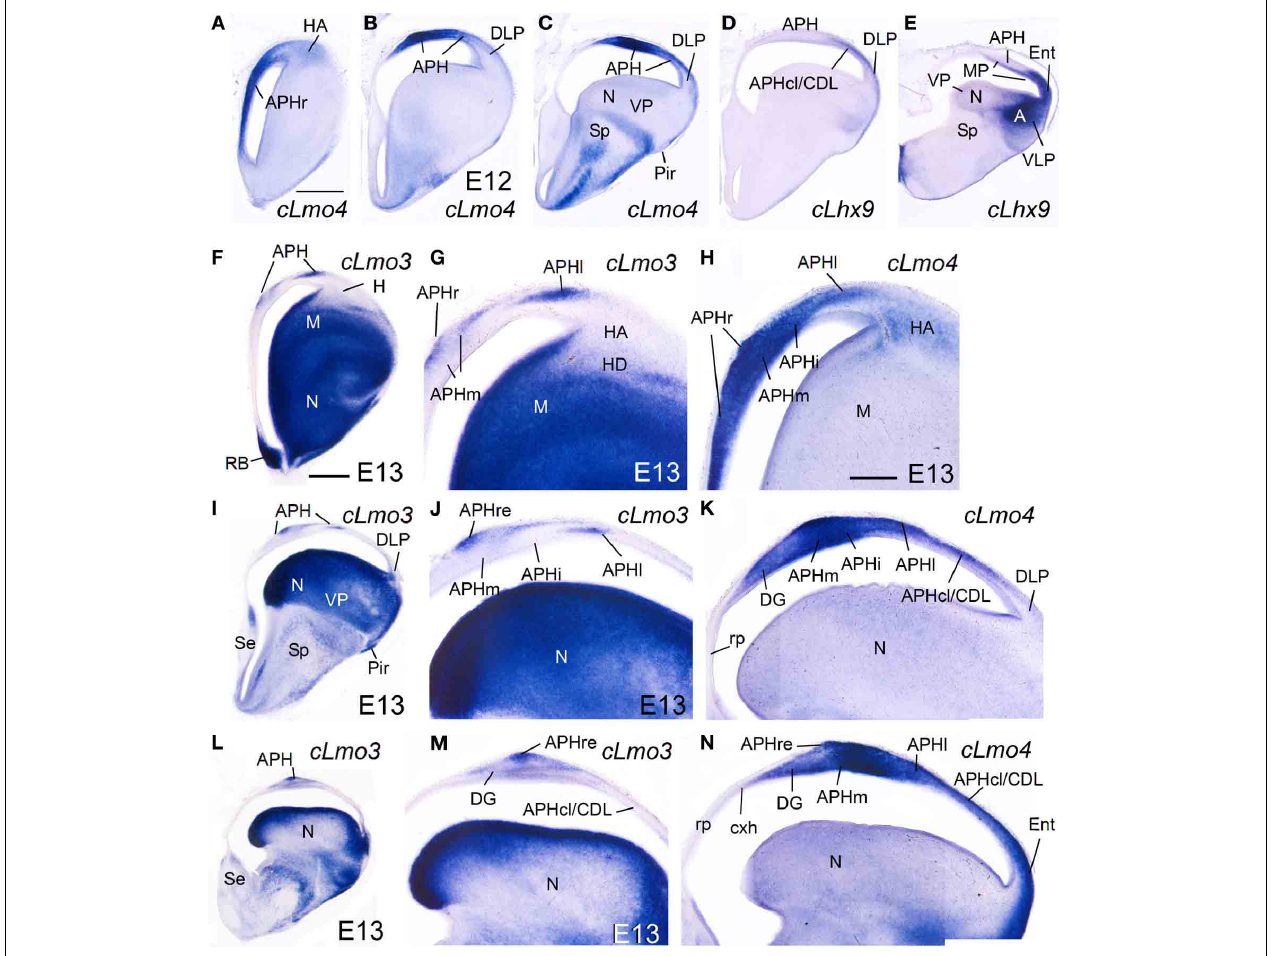
FIGURE 9 | Expression of several genes in the chicken embryonic telencephalon at intermediate stages. Digital images of coronal sections of chicken embryonic telencephalon (E12, E13), at rostral (A,F–H) , intermediate (B–D, I–K) or caudal (E, L–N) levels, hybridized for cLhx9, cLmo3 , or cLmo4 . Note the strong expression of cLmo4 in medial pallial derivatives, which is remarkable in APHm and APHi. cLhx9 is also expressed in the vz of the medial